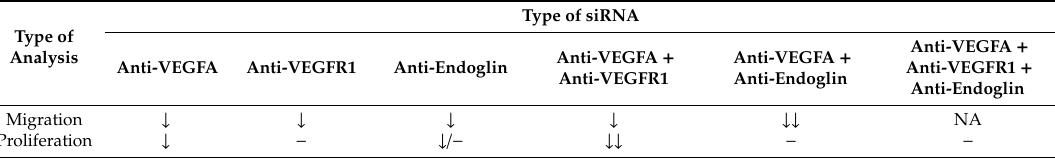
Table 1. Summary of registered anti-angiogenic e ff ects after anti-VEGFA, anti-VEGFR1, or anti-endoglin siRNA delivery and co-delivery mediated by an L1 vector ( ↓ means decrease of migration / proliferation; − means no e ff ect; ↓ / − means e ff ect detected only by Alamar Blue assay; ↓↓ means synergistic e ff ect; NA means absence of data due to